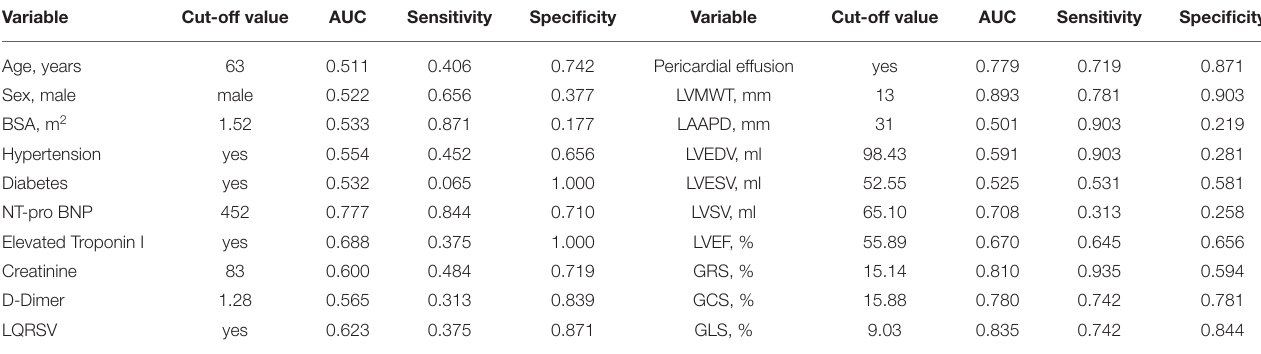
TABLE 2 | AUC of all variables in differentiating AL CA + patients from AL CA- patients. Variable Sensitivity Specificity